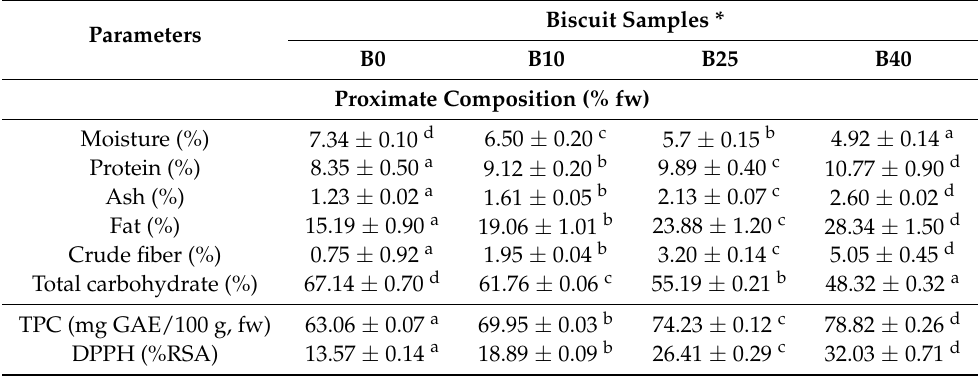
Biscuit Samples